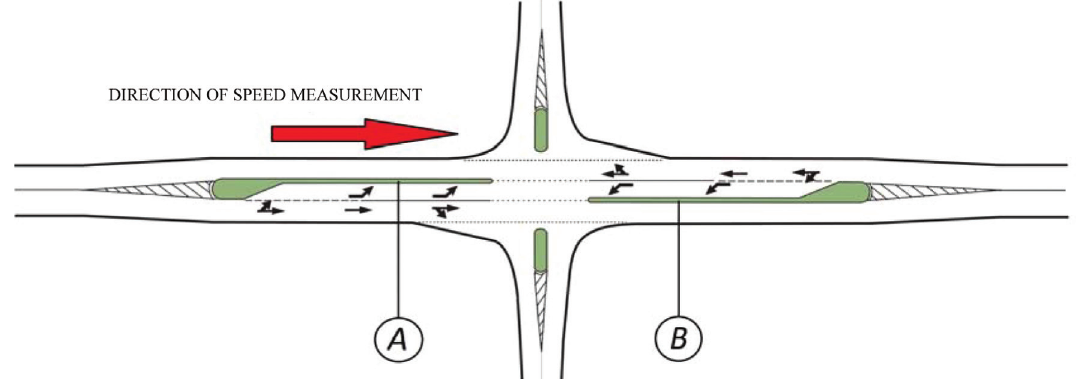
Fig. 7. Speed measuring scheme